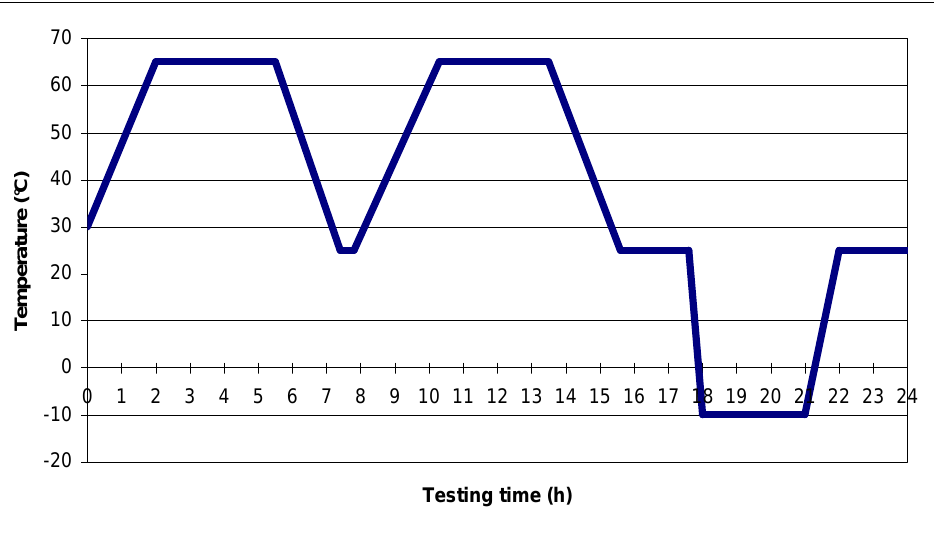
Figure 3. Standard IEC-68-2-38 for